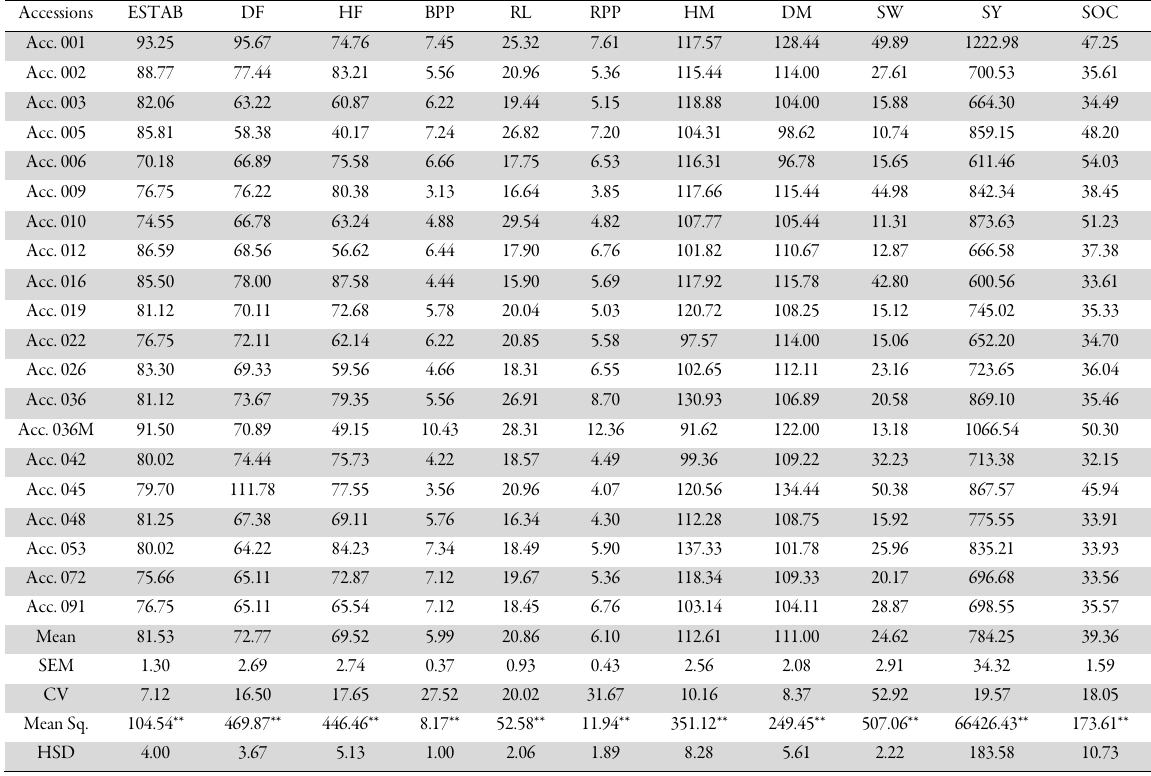
Table 3. Mean performances of 20 castor genotypes for 11 agronomic traits at